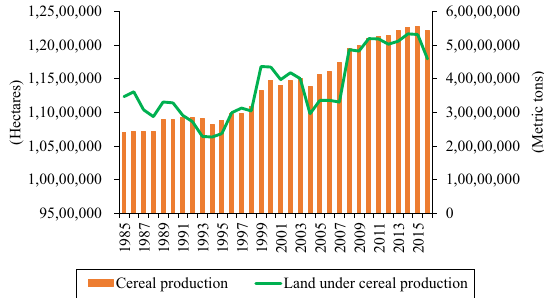
Figure 1. Per capita CO 2 emissions in Bangladesh